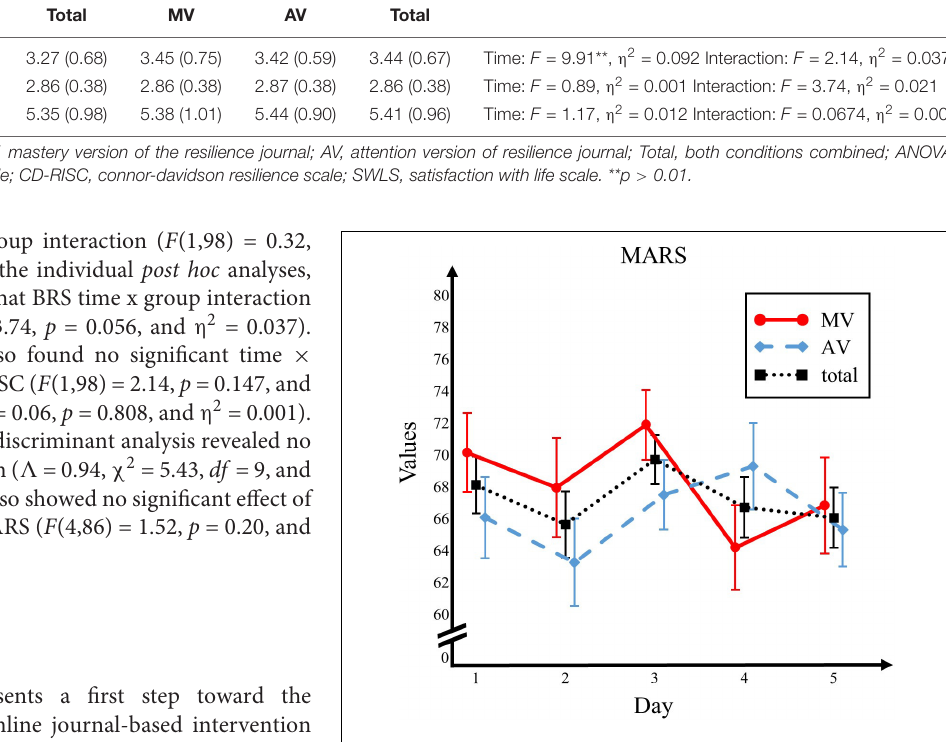
FIGURE 1 | Trends in Monitoring of Actual Resilience State (MARS). MV, mastery version of resilience journal; AV, attention version of resilience journal; Total, both conditions